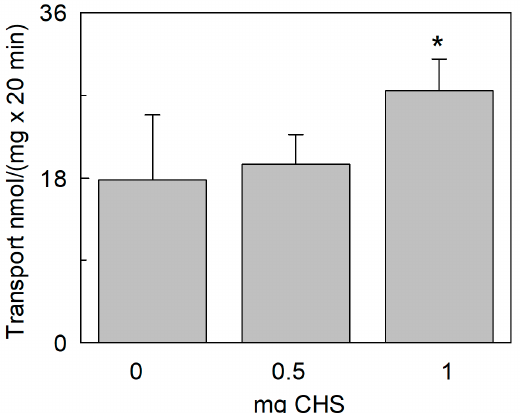
Figure 10. Effect of cholesteryl hemisuccinate (CHS) on the transport activity of Sl CAT2. Sl CAT2 was purified and reconstituted in proteoliposomes as described in Section 4.4. Transport was measured in 20 min, as described in Section 4.5, by adding 100 µM [ 3 H]Arg to proteoliposomes containing 200 mM sucrose and 15 mM ATP at pH 7.5. Proteoliposomes are prepared without CHS or with 0.5 mg or 1 mg CHS in 1 mL of proteoliposomes as described in Section 4.6. Results are the means ± SD from four experiments. (*), significantly different from the control (condition with no addition of CHS) for p < 0.05 as calculated from Student’s t -test analysis.